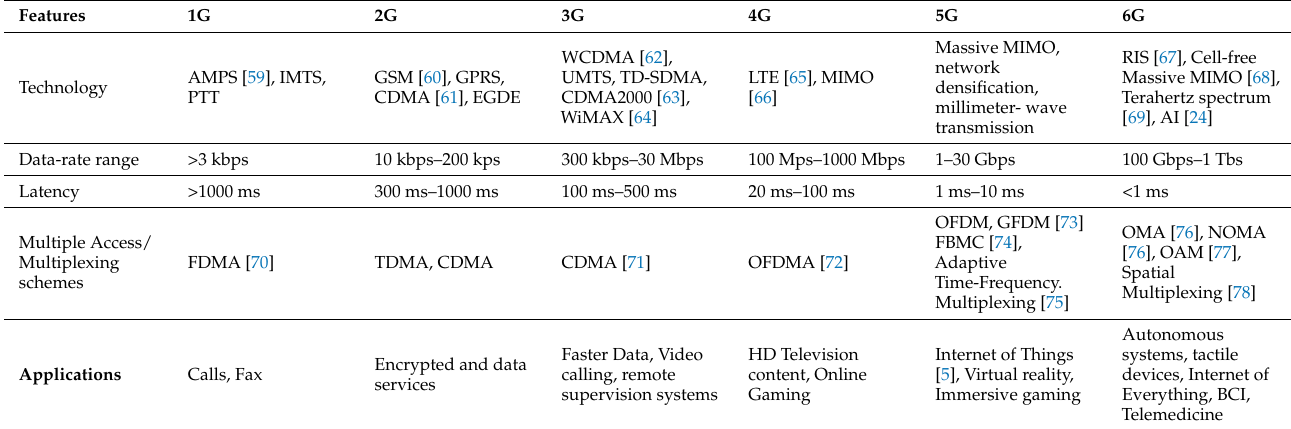
Table 2. Comparing the different generations of wireless communication from 1G to 6G.